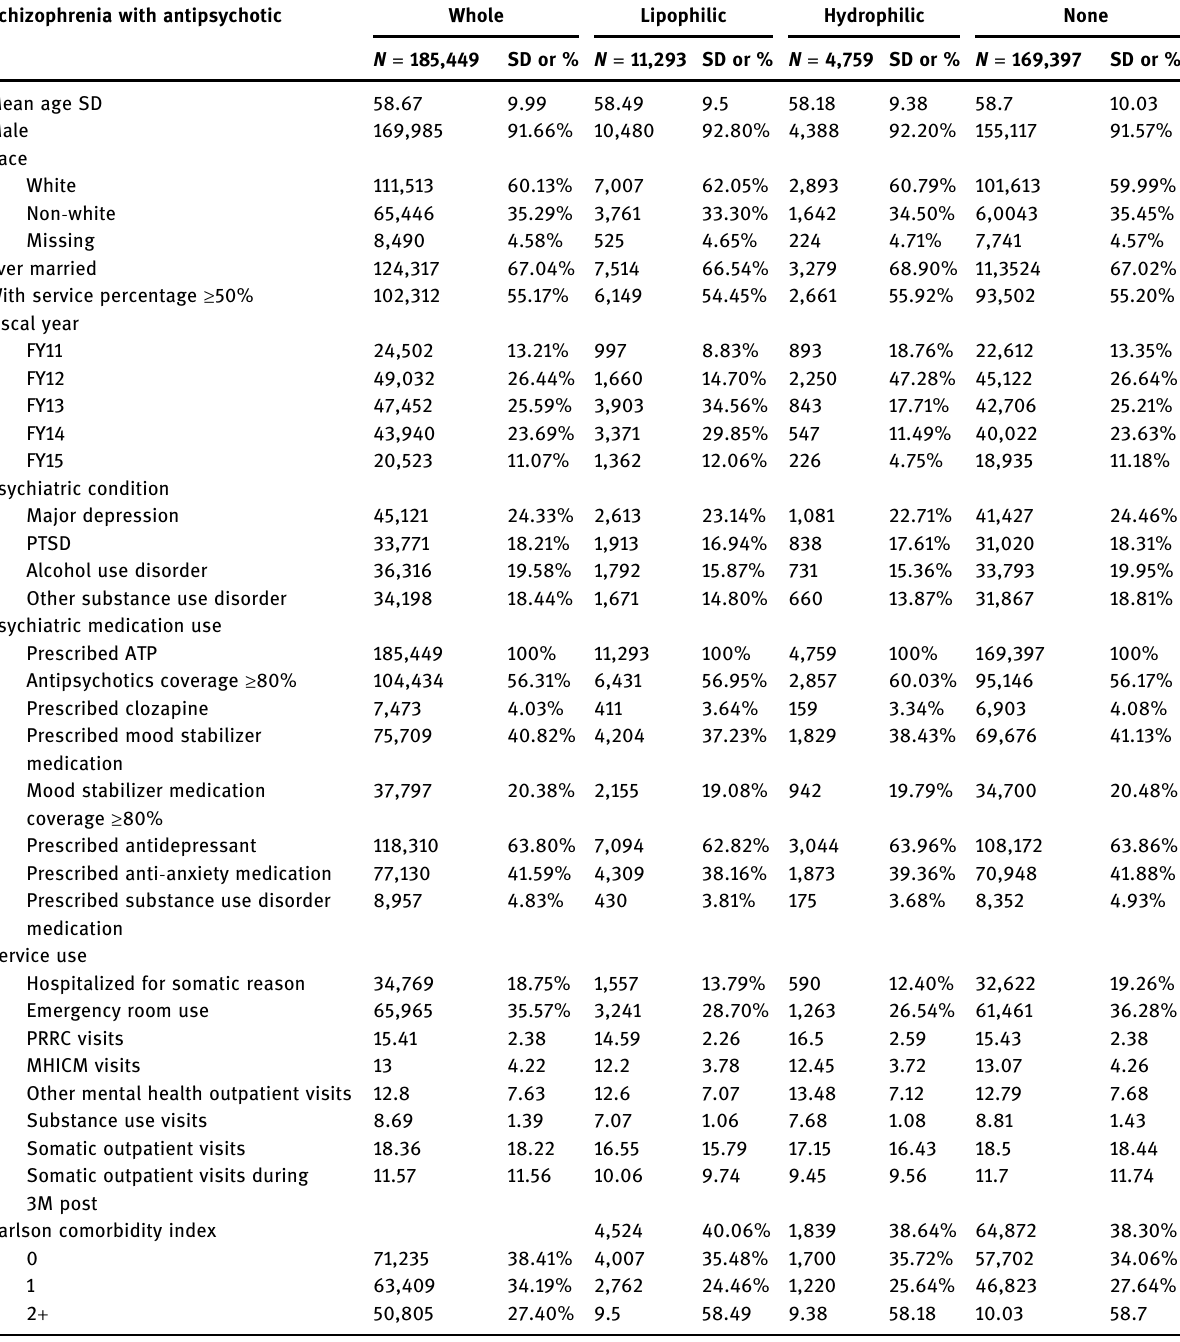
Table 1: Description of individuals with schizophrenia on antipsychotic medication Schizophrenia with antipsychotic Whole Lipophilic